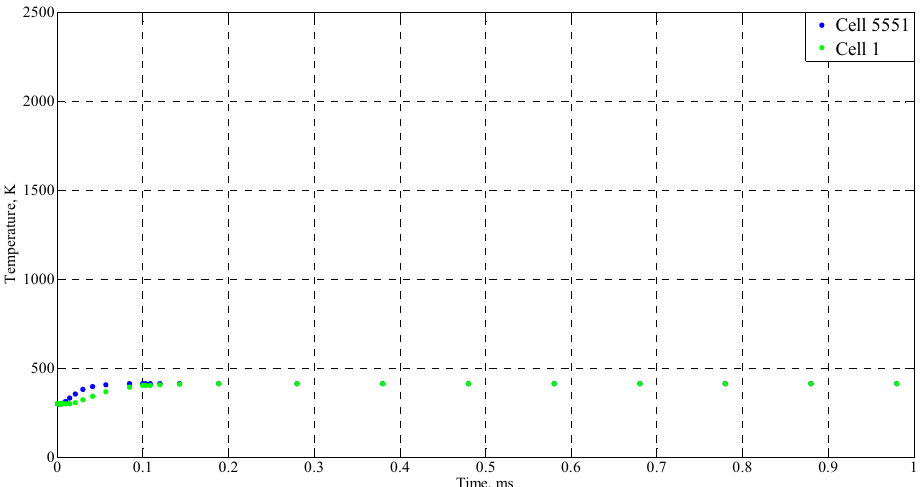
Figure 14. Temperature evolution in the steel cells 1 and 5551.